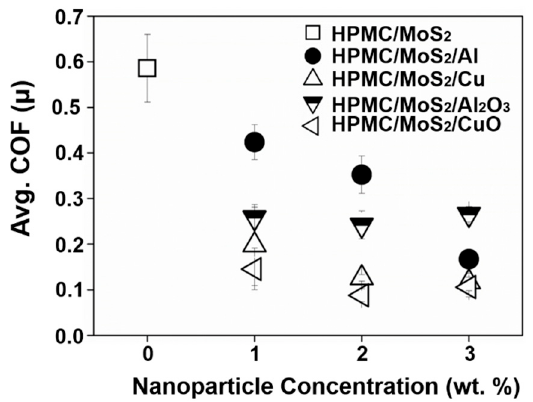
Figure 6. Average coefficient of friction of the HPMC/MoS 2 /additive composites (sliding distance 100 m).